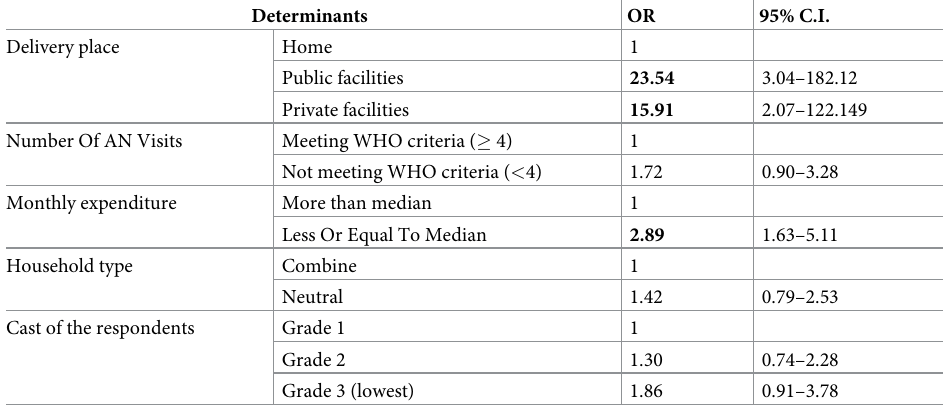
Table 6. Determinants of reported D & A- results from multiple regression